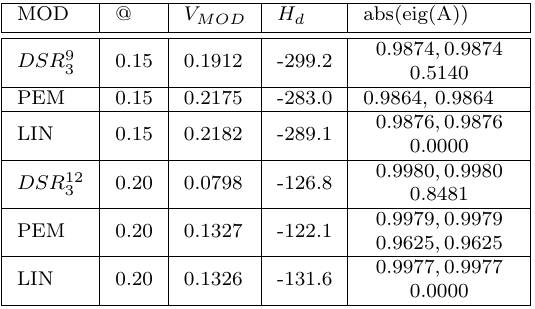
Table 1: Summary: Comparing models from DSR J PEM and Linearized (LIN). We have the pre- diction error for simulated output, V MSE , the steady state gain, H d , and absolute eigenval- ues, abs ( eig ( A )), for each of linear models, Mod. @ means around working point.